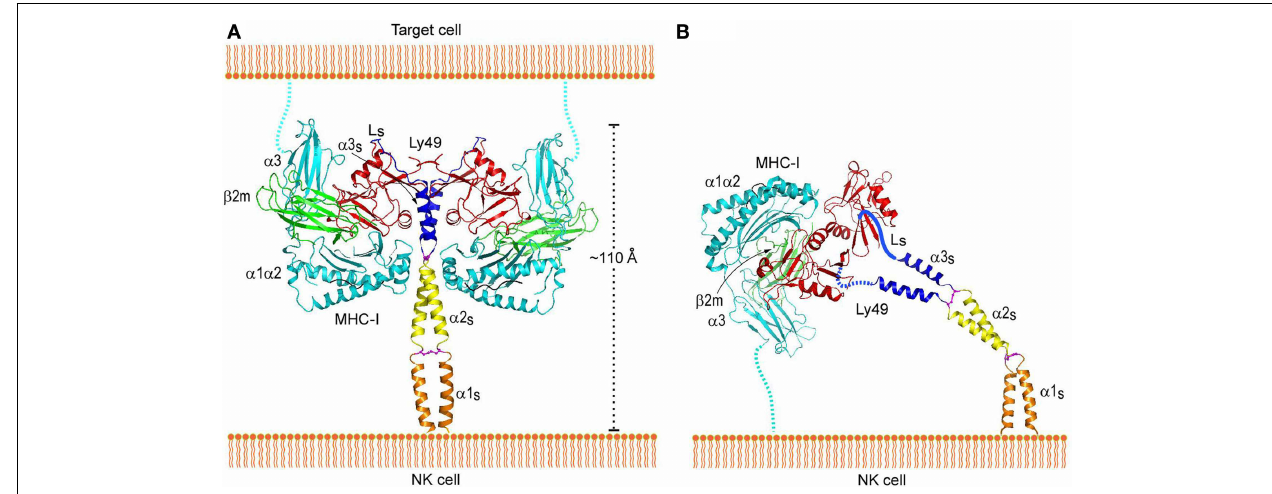
To bind in trans , the stalks must adopt a backfolded conformation, as the FIGURE 8 | Interaction of Ly49 receptors with MHC-I in trans and cis . N-termini of the Ly49 monomers point away from the NK cell membrane (A) Trans interaction of an Ly49 receptor with two MHC-I molecules, based (Ly49s are type II transmembrane proteins). (B) Cis interaction of Ly49 with on the structures of Ly49L (3G8L) and the Ly49C–H-2K b complex (3C8K). MHC-I, based on the structure of Ly49L and the Ly49A–H-2D d complex The α 1, α 2, and α 3 domains of the MHC-I heavy chain are cyan; β 2 m is (1QO3).The L S loops connecting the α 3 S helices to the NKDs are drawn green; Ly49 NKD is red; helix α 3 S of the Ly49 stalk and loop L S connecting α 3 α 3 arbitrarily.The Ly49 homodimer binds one MHC-I molecule on the NK cell S to the NKD are blue; the disulfide bond linking the S helices is itself. In this case, the stalks must assume an extended conformation, as magenta.The predicted α 1 S and α 2 S helices of the stalk are orange and the N-termini of the Ly49 monomers point toward the NK cell. Reproduced yellow, respectively, with the disulfide bond in magenta.The Ly49 with permission from Immunity homodimer on the NK cell binds two MHC-I molecules on the target cell.